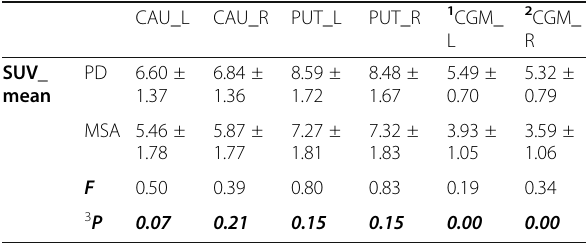
Table 3 The SUV mean quantification in brain nuclei for PD and MSA